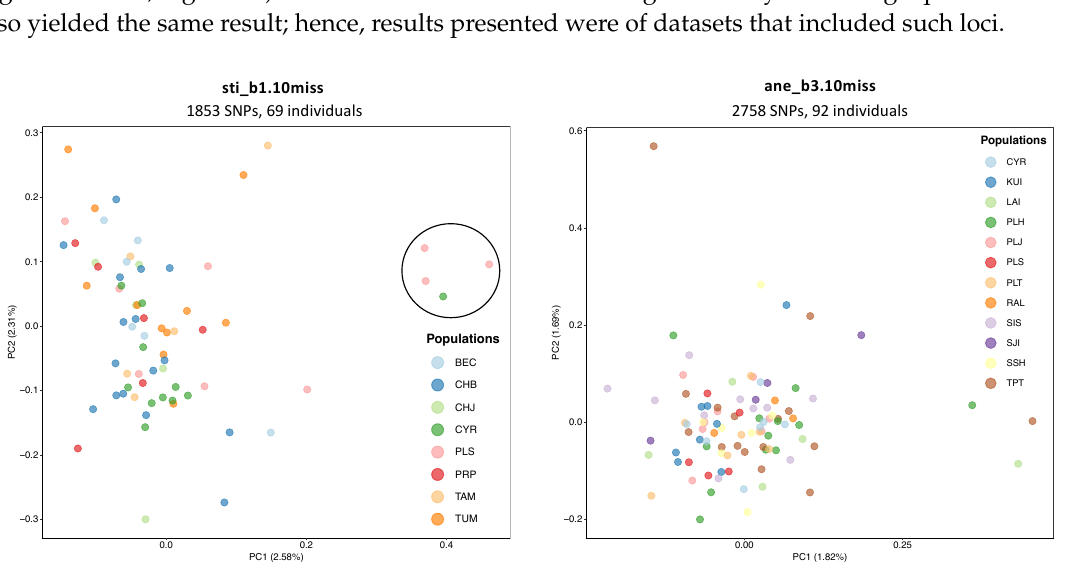
Figure 3. Principal coordinates analysis (PCA) of ( a ) Stichodactyla haddoni (sti_b1.10miss) and ( b ) Entacmaea quadricolor (ane_b3.10miss). Sampling sites are indicated with di ff erent colours. Four diverging individuals are